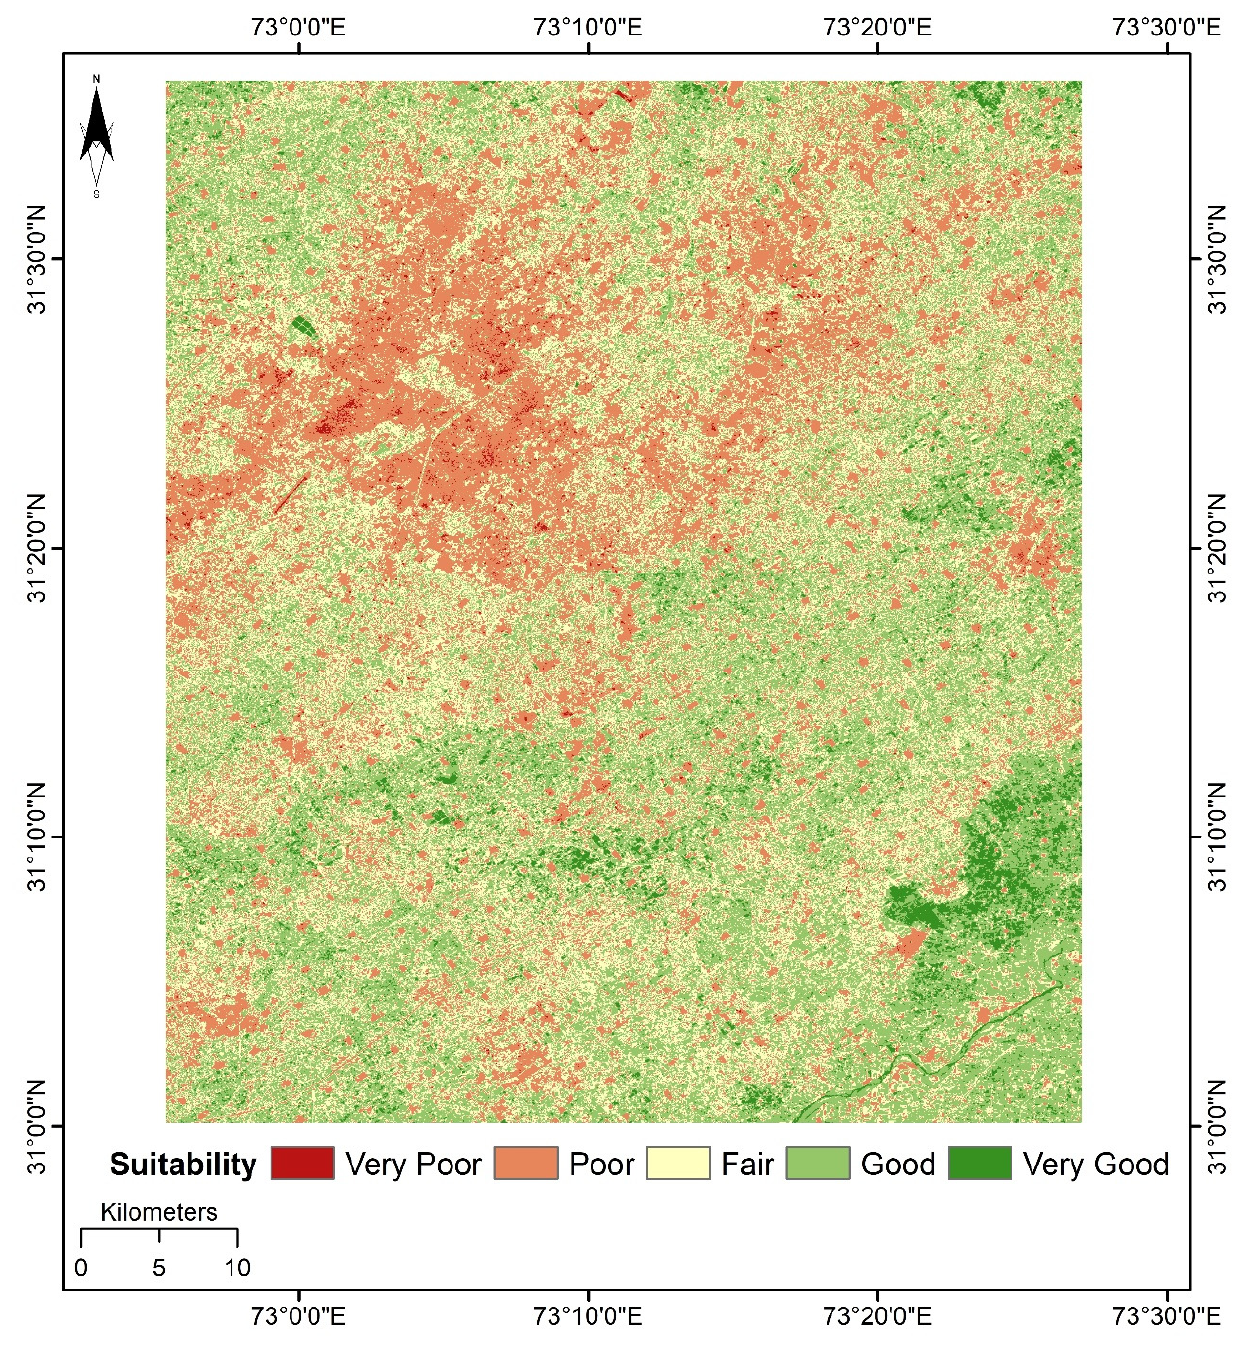
Figure 5. Suitability of Landfill